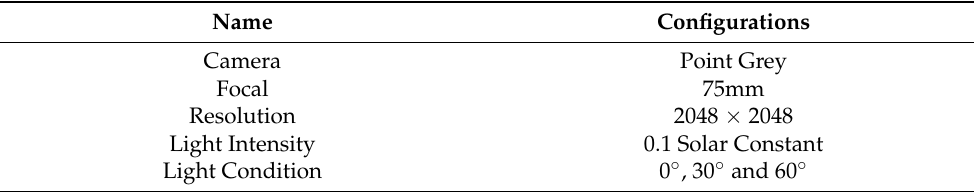
Table 1. Image shooting